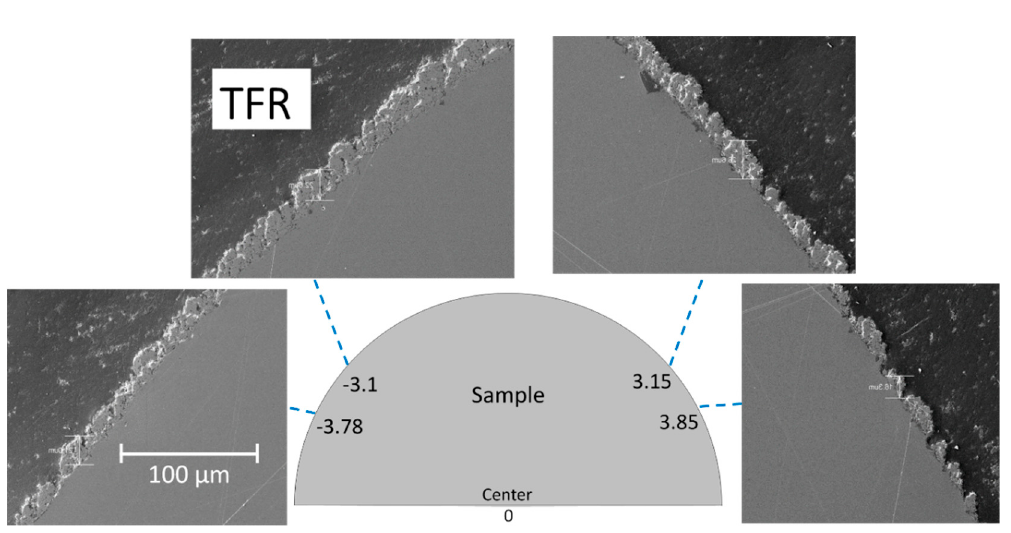
Figure 15. Cross-section images showing the columns on the rod sample with fine grit blasting (TFR).